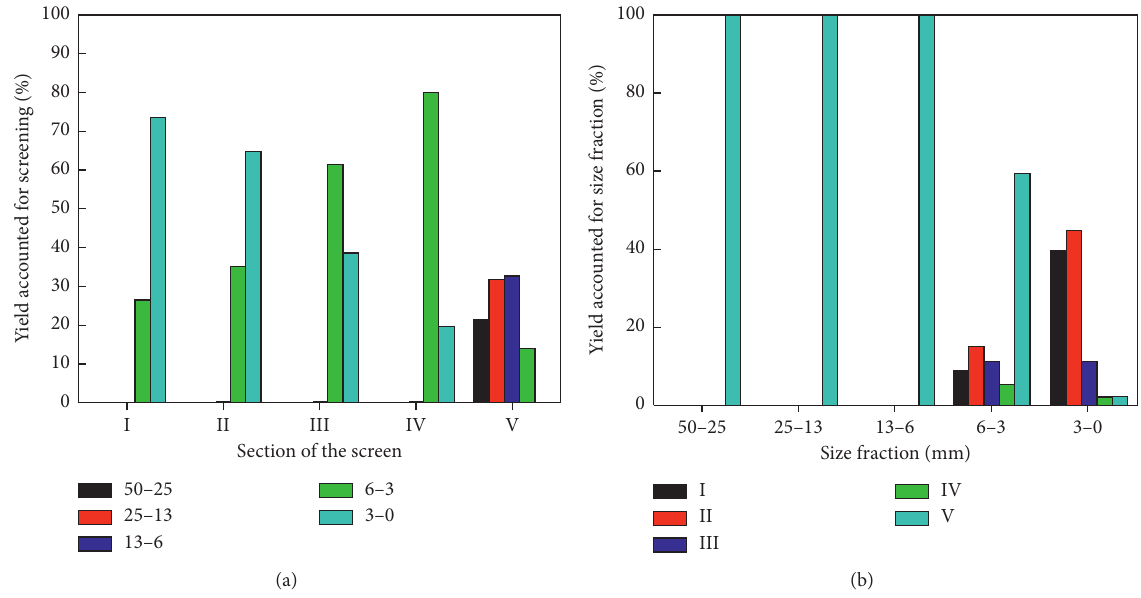
Figure 10: Distribution of various size fractions in different sections of the VFFS.